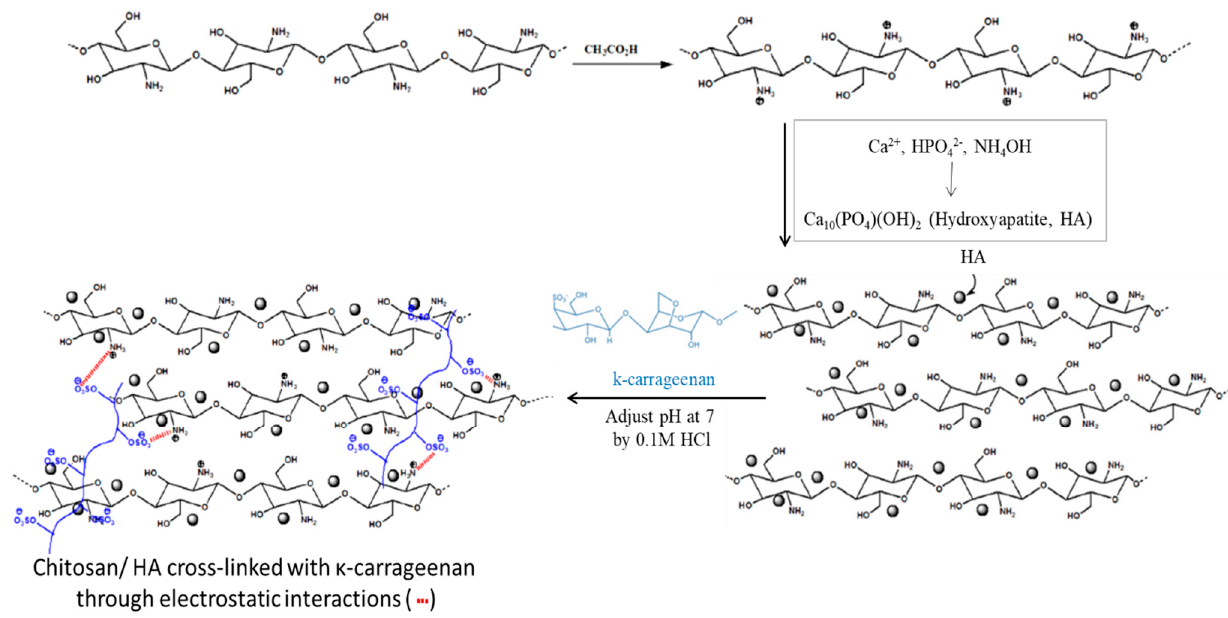
Figure 5. Preparation of κ -carrageenan-crosslinked chitosan/nanohydroxyapatite hydrogel via ionic interaction (adapted with permission from Mahdavinia et al., 2019).